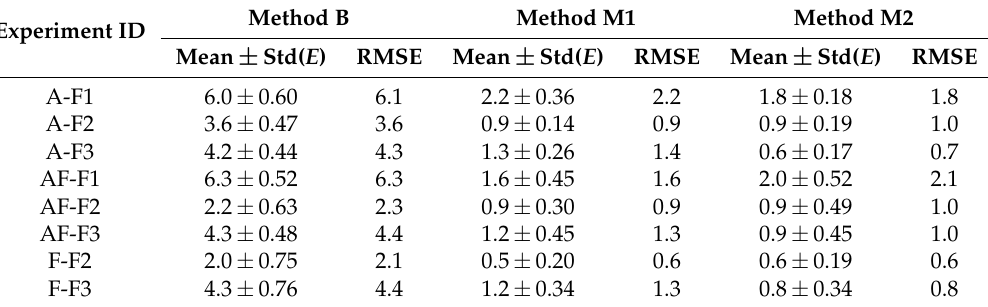
Table 6. Mean and standard deviation (std) of error E [cm] and RMSE [cm] for the evaluation of methods B, M1, and M2 when compared against an optical motion capture system in Setting 1